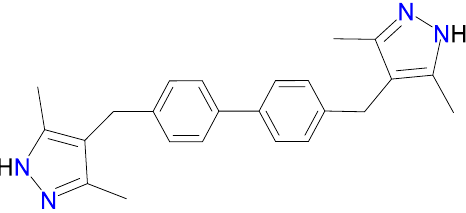
Figure 1. Structure of 4,4’ -bis((3,5-dimethyl-1H-pyrazol-4-yl)methyl)biphenyl (H 2